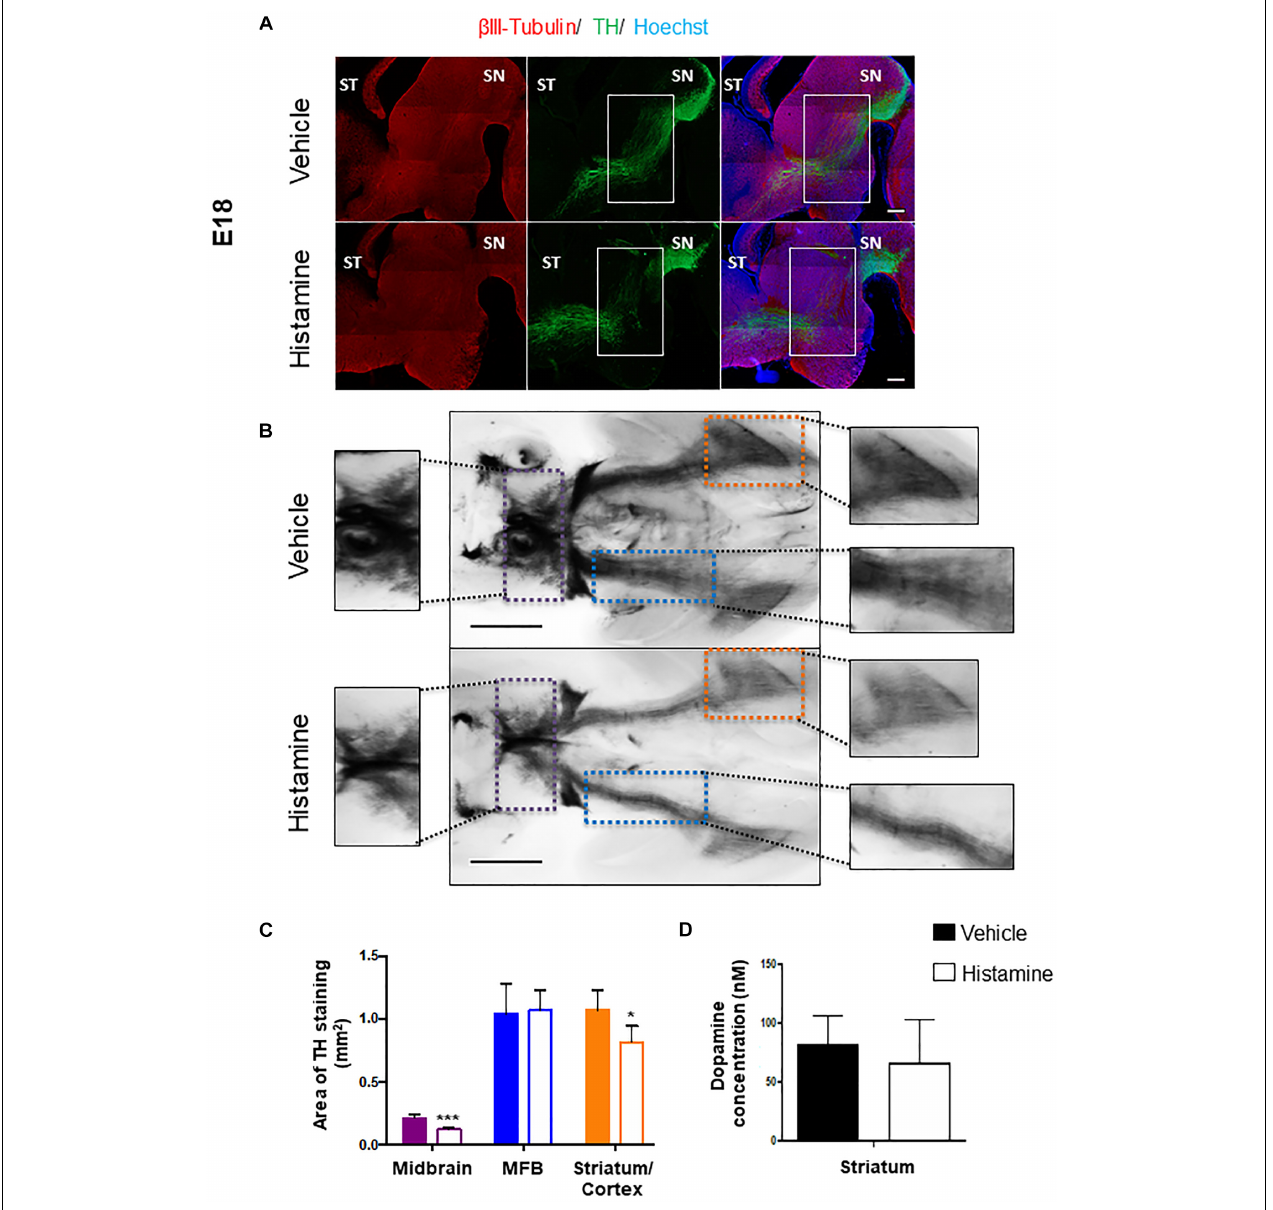
FIGURE 3 | Analysis of the midbrain dopaminergic projection pathways at E18, after injection of HA at E12. (A) Immunohistochemistry for the limiting enzyme in DA synthesis, TH, analyzed together with β -III Tubulin, in sagittal brain sections 6 days after injection of vehicle or HA. Regions with differences between the two experimental conditions in the nigrostriatal pathway are marked with the white rectangles. ST, striatum ; SN, substantia nigra . Scale bar: 500 µ m. (B) Ventral views of the whole-mount TH immunostainings of E18 brains from embryos injected with vehicle or HA. The midbrain area within the dotted purple lines, the Medial Forebrain Bundle (MFB) area within the dotted blue lines and the Striatum/Cortex area within the dotted orange lines, are amplified in the intermediate panels, and were used to measure the area of TH staining in 4 independent experiments. Scale bar: 1 mm. (C) Quantification of TH staining area of Midbrain, MFB and Striatum/Cortex (this region also includes the Nucleus Accumbens). ∗ p < 0.05 and ∗∗∗ p < 0.005. (D) Dopamine content quantification in the striatum of vehicle- or HA-injected embryos by HPLC. The dissection of this area was performed at E18 making sure to remove the cerebral cortex and the basal part of the brain. Solid and empty bars apply to panels C,D